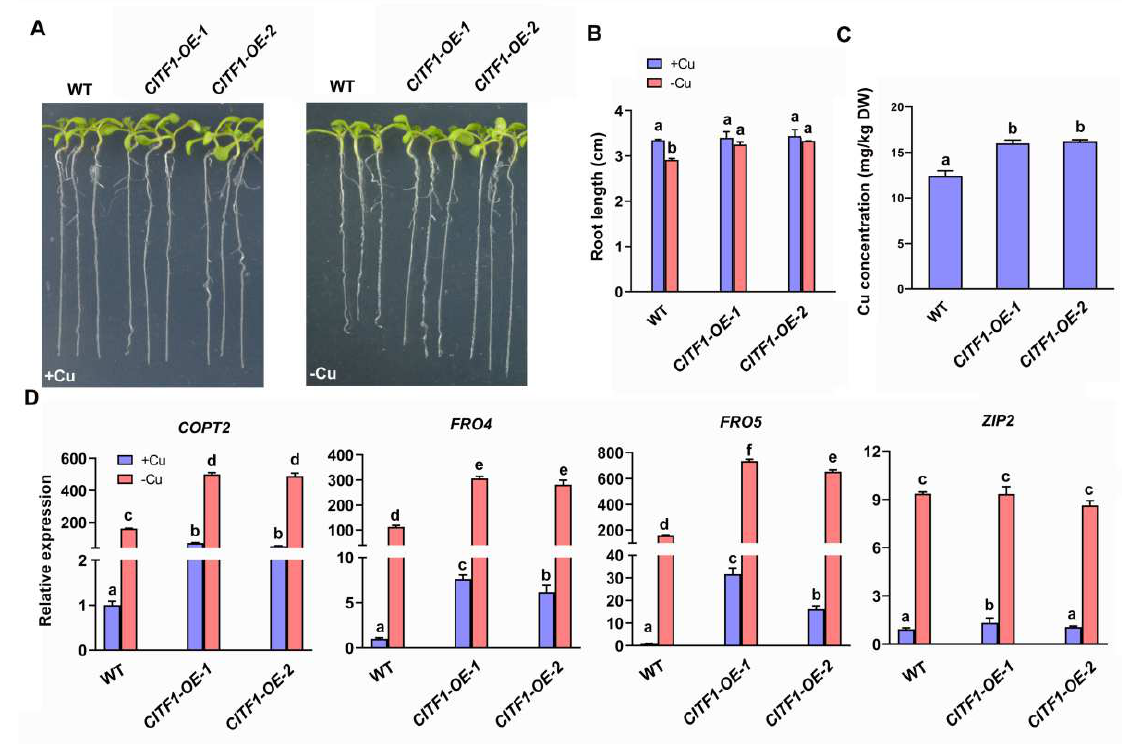
Figure 1. Overexpression of CITF1 enhances Cu uptake. ( A ) Seedlings were grown on +Cu or −Cu medium for 7 days. ( B ) Root length. Seven-day-old seedlings were analyzed. Three biological replicates were conducted. Data represent arithmetic means ± SD ( n = 3 biological replicates, each of which contained at least 15 plants). Different letters above each bar indicate statistically significant differences (ANOVA, p < 0.01). ( C ) Cu concentration. Leaves from plants grown in soil for 3 weeks were used for Cu measurement. Data represent arithmetic means ± SD ( n = 3 biological replicates, each of which contained 100 mg pooled dry leaves). Different letters above each bar indicate statistically significant differences (ANOVA, p < 0.01). ( D ) Expression of Cu-deficiency responsive genes. Seedlings were grown on +Cu or − Cu medium for 7 days. Roots were used for RNA extraction. Data represent arithmetic means ± SD ( n = 3). Different letters above each bar indicate statistically significant differences (ANOVA, p < 0.01).